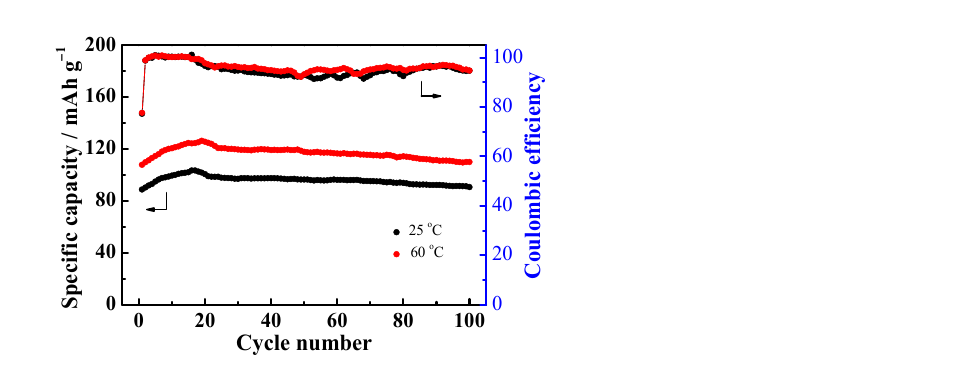
Figure 7. Cycling performances of the LIBs with TLPEC electrolyte at 25 and 60 °C. The charge and discharge current density was 1 C. Table 1. Discharge specific capacities of LIBs with various ionic liquid-based electrolytes reported in the literature. Electrolyte